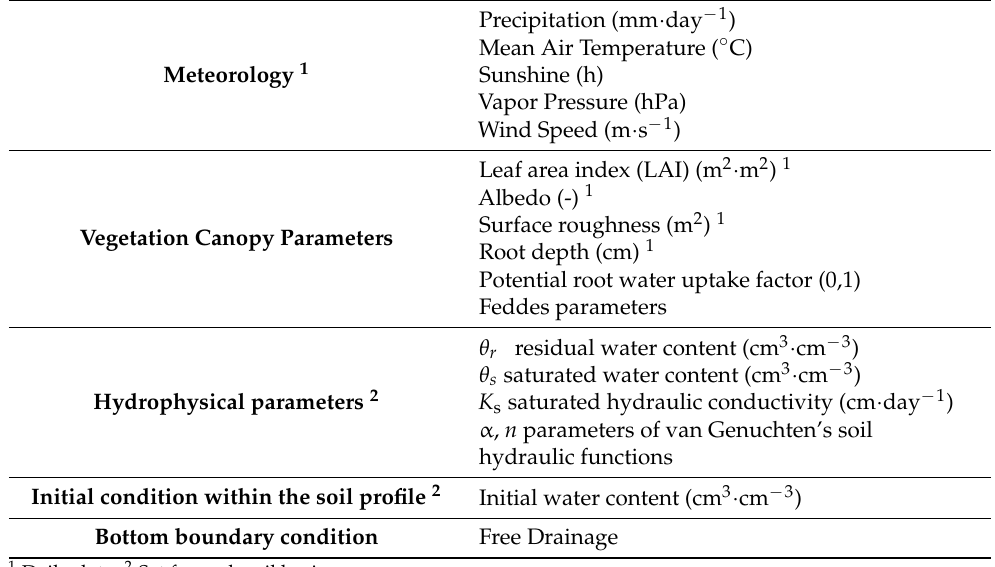
Table 1. Summary of the inputs to the GLOBAL